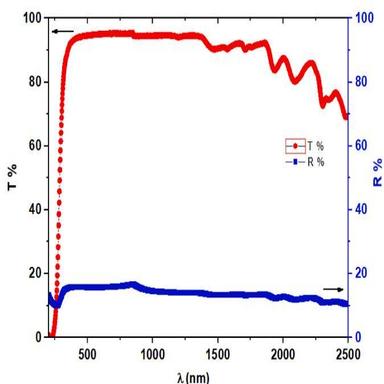
Spectral distribution of transmittance, T, and reflectance, R of PVA structure.